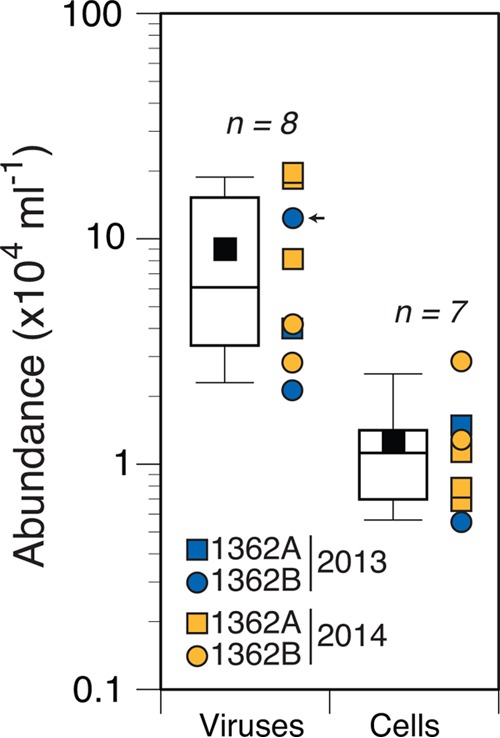
Concentrations of putative viruses (n = 8) and prokaryotic cells (n = 7) in basaltic basement fluids as determined by staining characteristics using epifluorescence microscopy. For each category, box-and-whisker plots are shown to the left and depict the mean (black square) and the 10th, 25th, 50th, 75th, and 90th percentiles of counts. The individual counts from 2013 (blue symbols) or 2014 (orange symbols) for CORK U1362A (squares) or U1362B (circles) are shown to the right of the box-and-whisker plots. In one instance (indicated by a small black arrow), only a filtered sample (<0.2 µm) was available, so only viruses were counted.